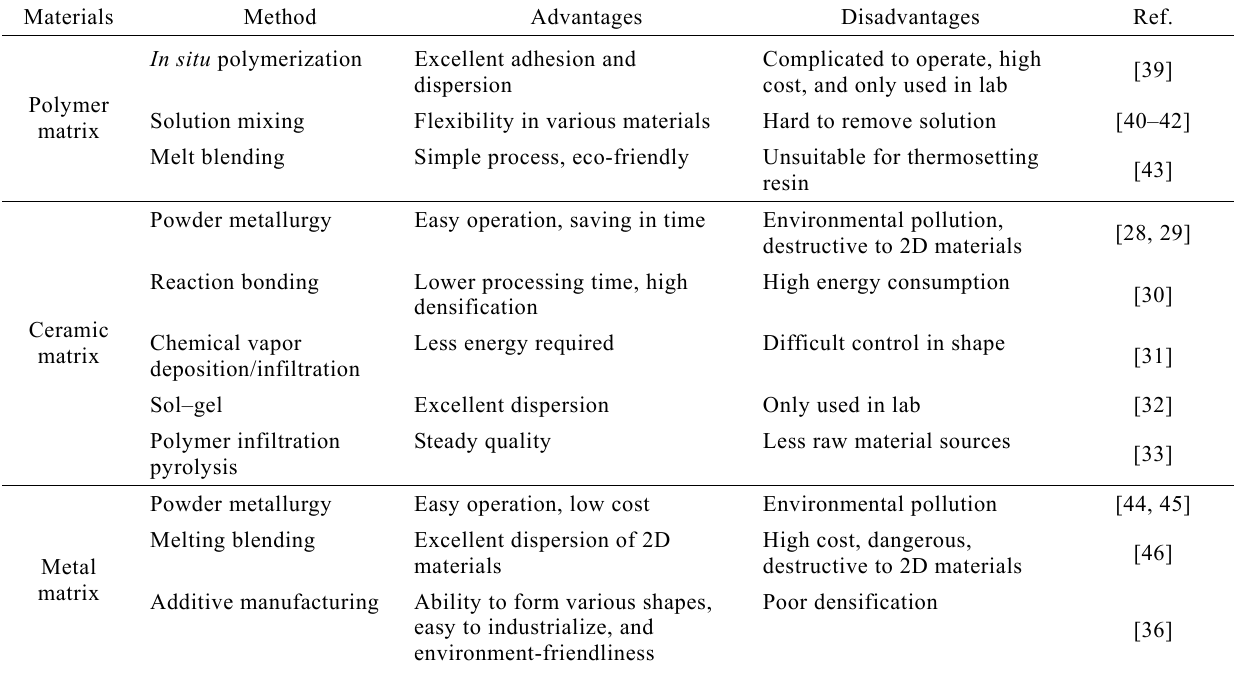
Table 2 Summary of preparation methods for